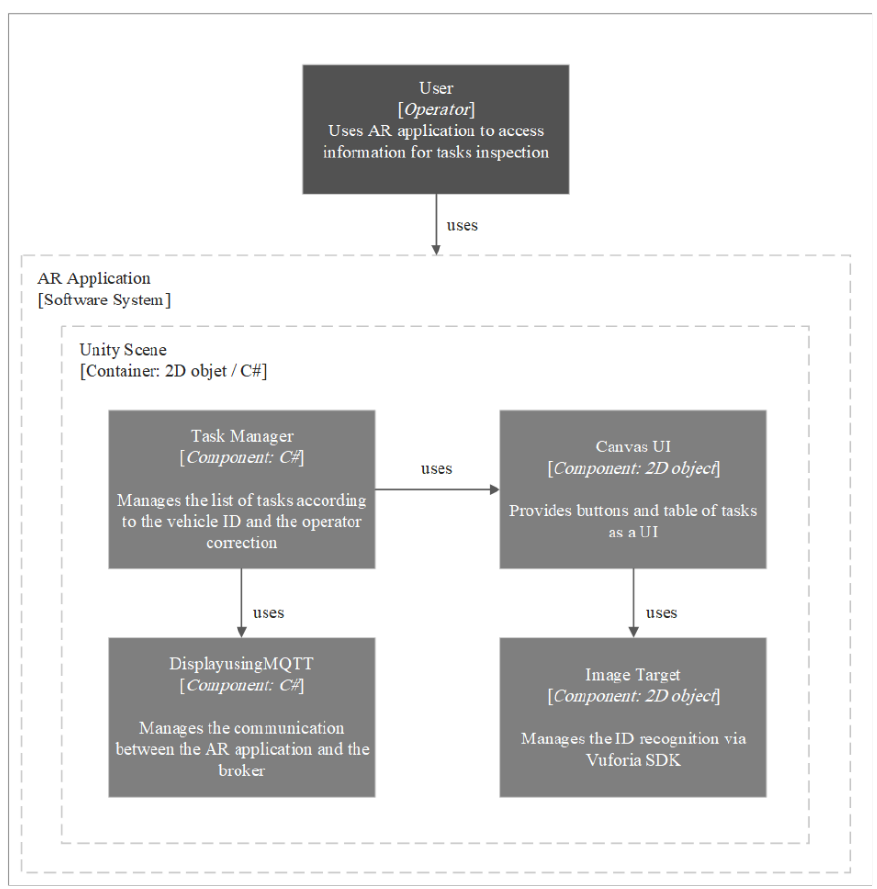
Figure 4. The software framework of the cognitive system.